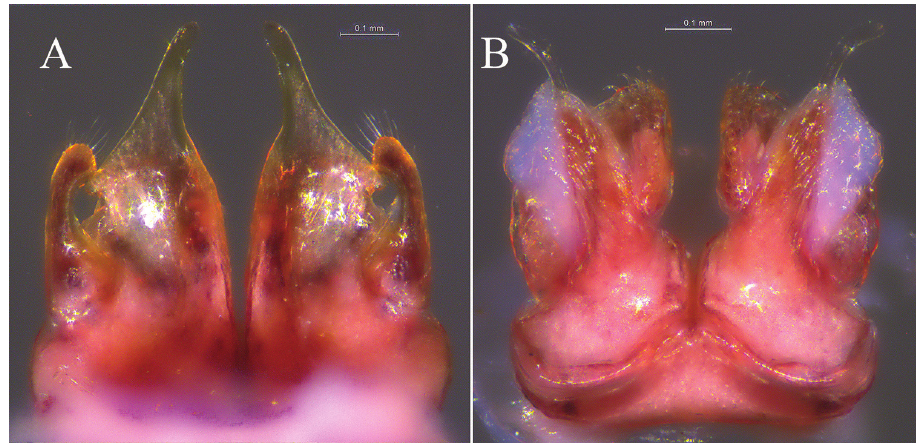
Figure 19. Glyphiulus impletus sp. n., holotype. A anterior gonopods, caudal view B posterior gonopods, caudal